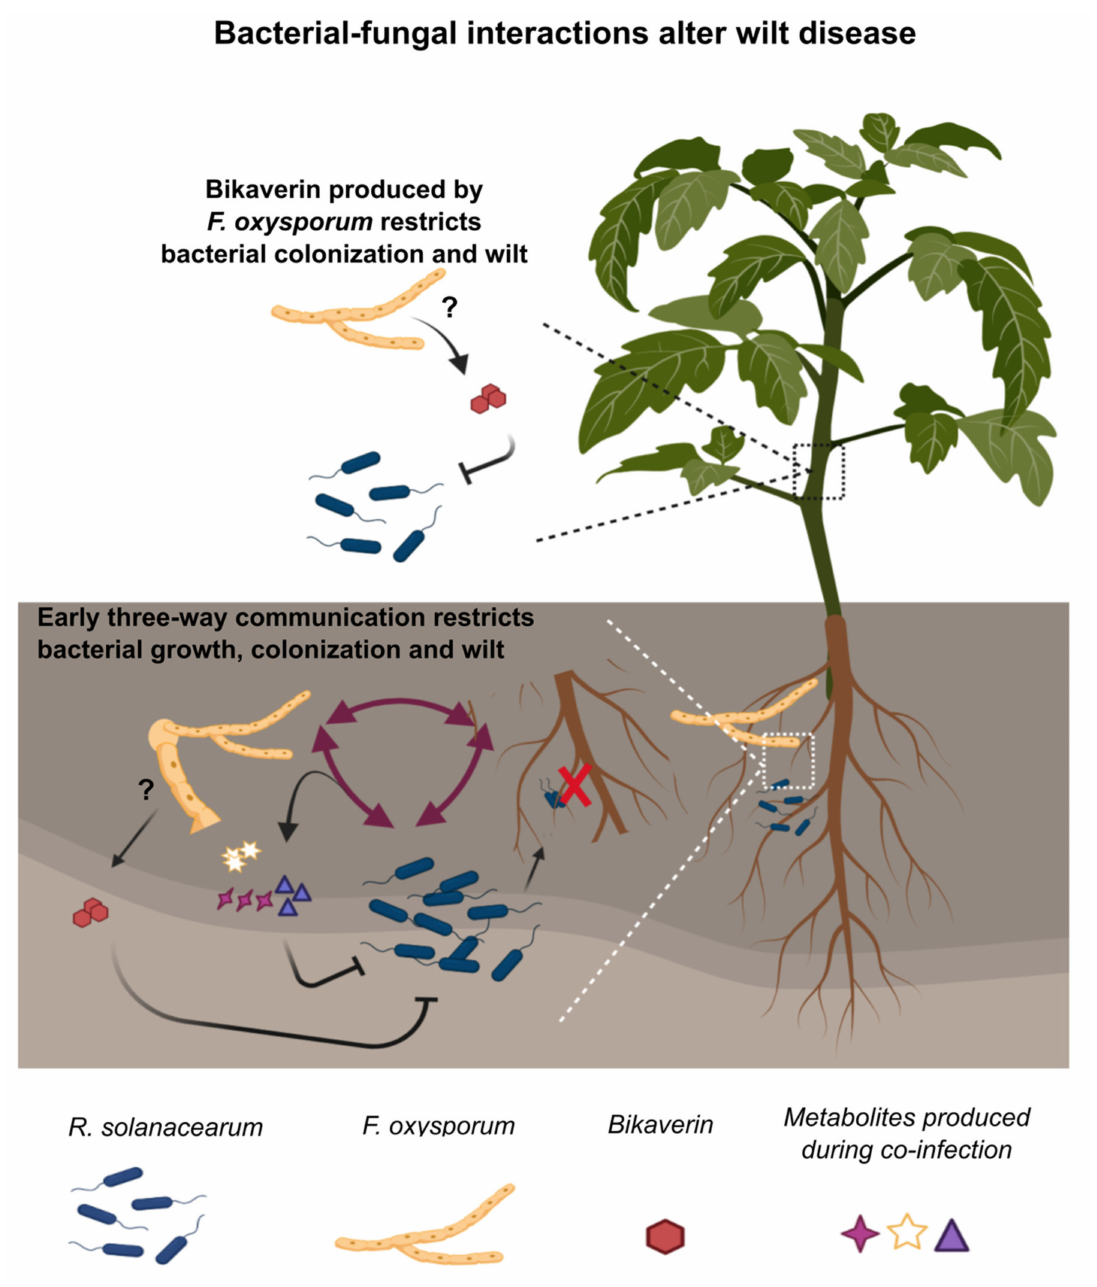
Figure 6. Model for tri–trophic interactions mediating wilt disease. Early interactions between the microbes and the host at the root result in the production of secondary metabolites that inhibit R. solanacearum growth and colonization. In the presence of the bacterium, F. oxysporum produces bikaverin, whose antibacterial activity also contributes to reduced colonization by R. solanacearum. Whether bikaverin is produced in the rhizosphere or in later stages inside the plant remains to be answered (represented with a question mark). This figure was created with